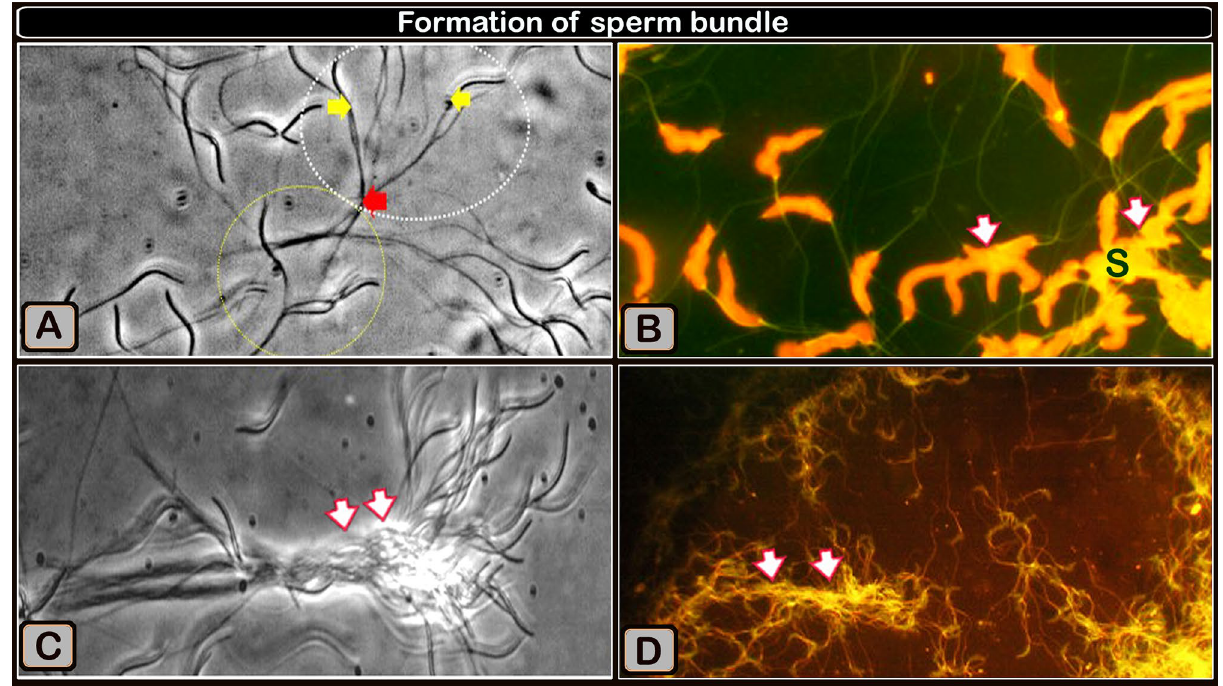
Figure 3. Formation of sperm bundles using a phase contrast microscope and an acridine orange-stained sperm smear showing that the sperm head sticking together. ( A ) The early formation of sperm bundles started with sperm (white circle) and three sperm (yellow circle), and the spiral started at the tail and finally at the head. ( B ) Micrograph of a semen smear stained with acridine orange showing that the sperm head stucking together (arrows). The secretion covers the heads (S). Magnification ×1000. ( C ) The developed of large bundles transported through the flow in the micro fluid channel (using a high-speed camera at 950 frames/s). ( D ) Acridine orange-stained sperm smear micrograph showing the formation of large bundles (arrows). Magnification: